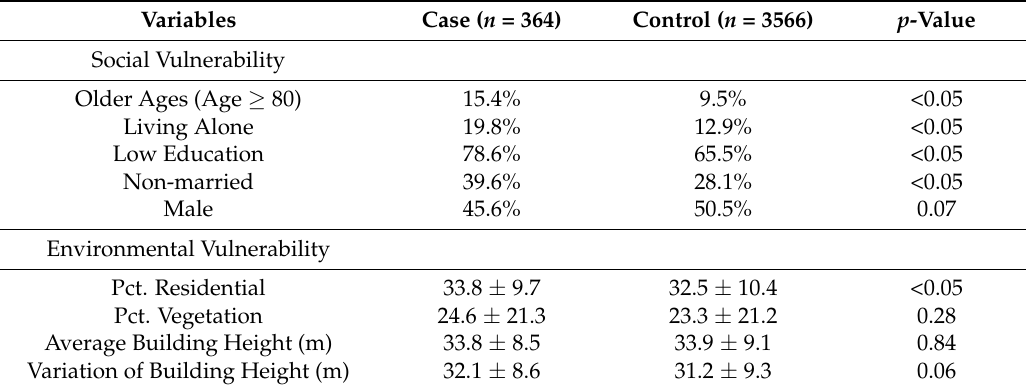
Table 1. Summary table for the percentage of subjects of all social variables for case and control groups.